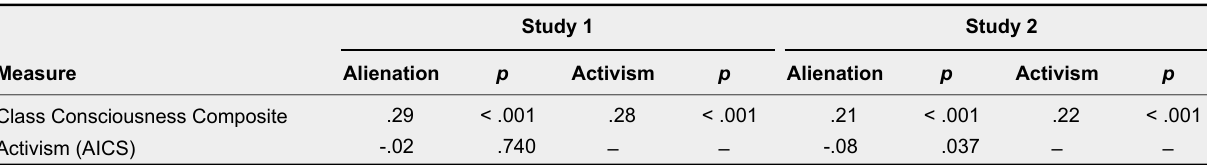
Pearson Correlations Between Class Consciousness, Alienation, and